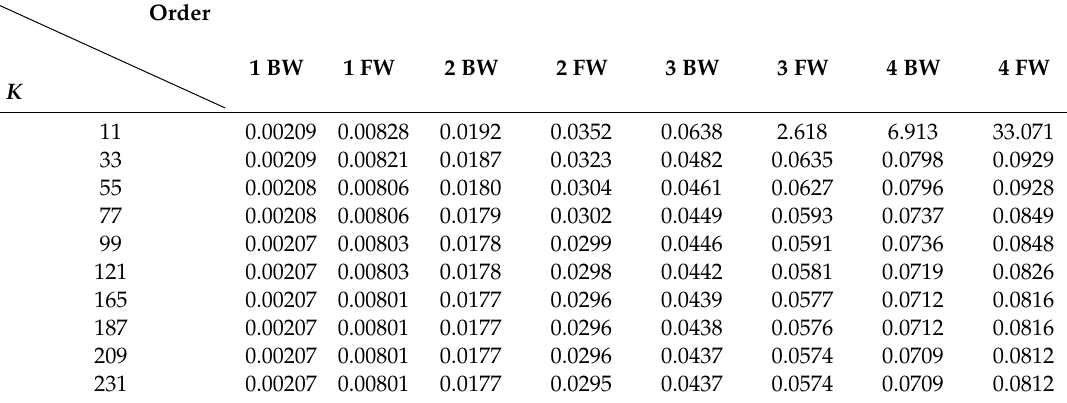
Table 8. Natural frequencies via modal discretization ( h = 2000 Nms).